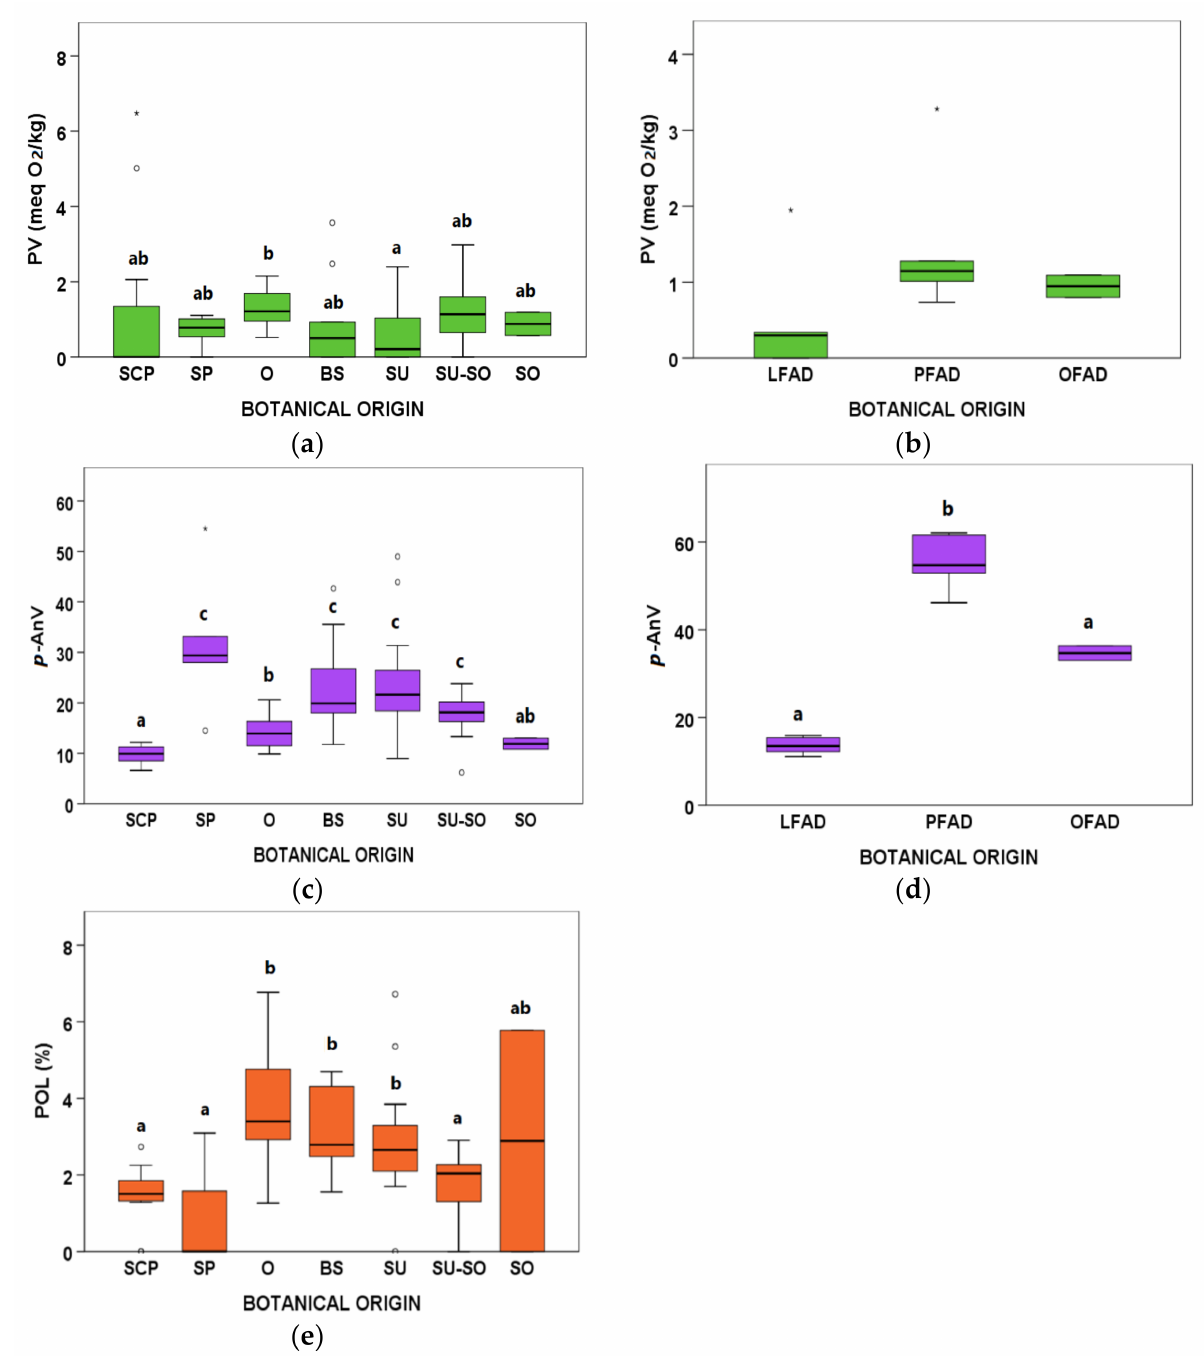
Figure 2. Peroxide value (PV), p -Anisidine value ( p -AnV), and polymeric compounds (POL) boxplots according to botanical groups for ( a , c , e ) acid oils (AO) from chemical refining ( n = 79), and ( b , d ) fatty acid distillates (FAD) from physical refining ( n = 13) (see Table 1 for abbreviations of botanical groups). Within each type of byproduct (AO or FAD) and variable, botanical groups bearing different letters (a–c) show significantly different medians ( p ≤ 0.05) according to Kruskal–Wallis test and stepwise multiple comparisons for independent samples. ◦ Outliers: samples with values between (Q3 + 1.5 × IQR) and (Q3 + 3 × IQR) or between (Q1 − 1.5 × IQR) and (Q1 − 3 × IQR). * Extreme outliers: samples with values above (Q3 + 3 × IQR) or below (Q1 − 3 × IQR). No POL were detected in